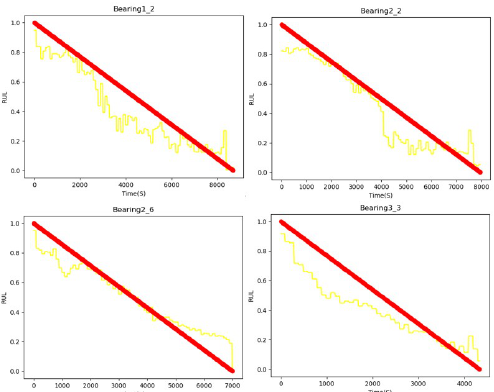
Figure 6. The RUL prediction results of selected bearings.